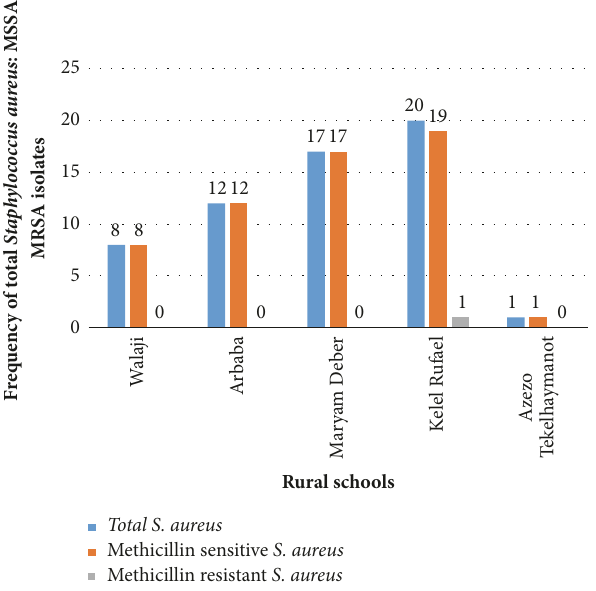
Figure 2: Frequency of total Staphylococcus aureus , MSSA, and MRSA in five rural elementary school children, surrounding Gondar town, Northwest Ethiopia,